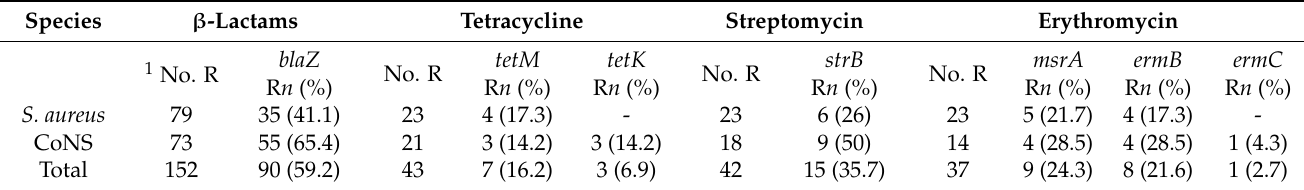
Table 3. Antimicrobial resistance genes to various antibiotics among the staphylococci isolates from bovine mastitis in two counties in